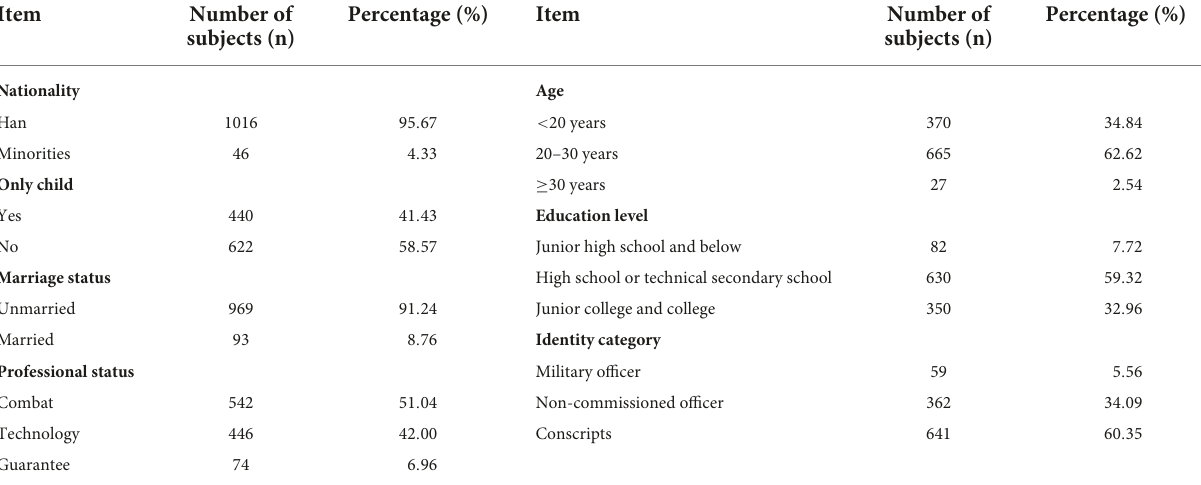
TABLE 1 General demographic data ( n =